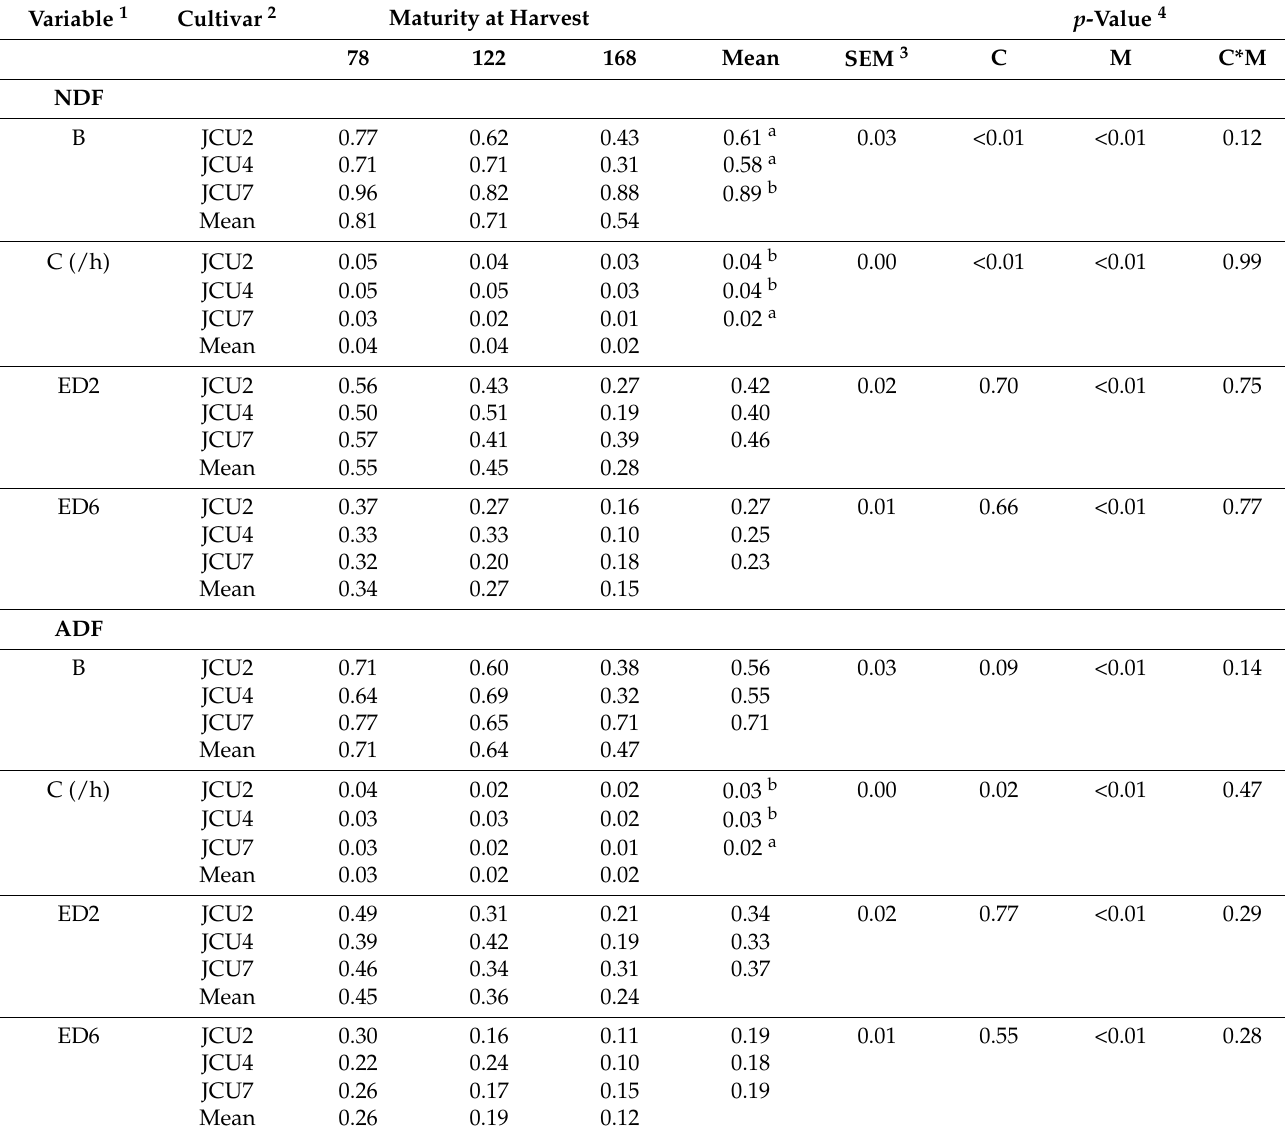
Table 6. Effect of cultivar and maturity stage at harvest of desmanthus on in situ neutral deter- gent fibre (NDF) and acid detergent fibre (ADF) degradation. Data presented in fractions unless otherwise